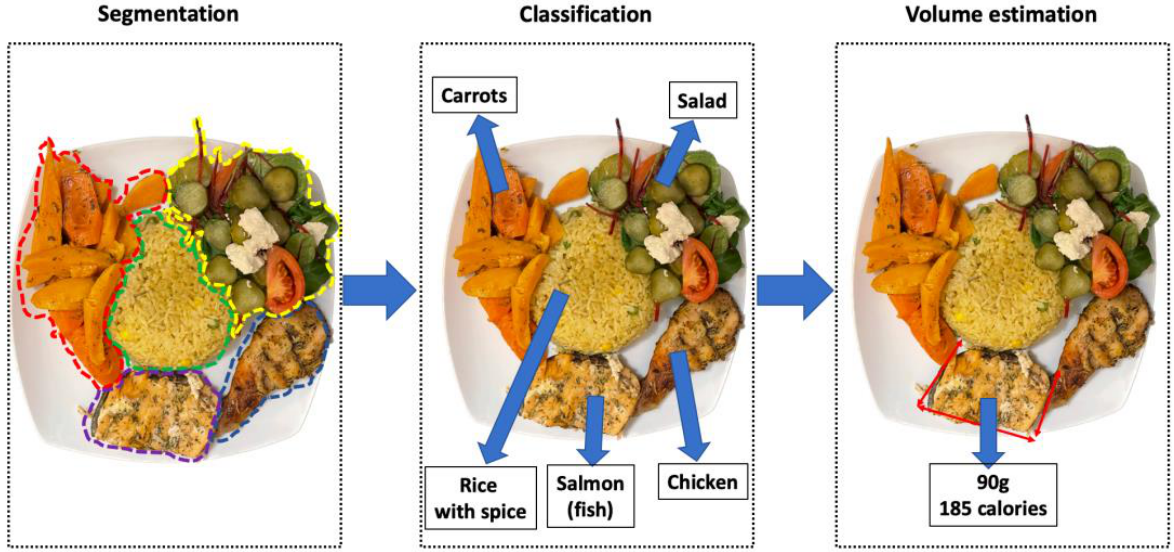
Figure 3. The schematic workflow shows the steps for image-based dietary assessment: segmentation, classification, volume and calorific estimation.